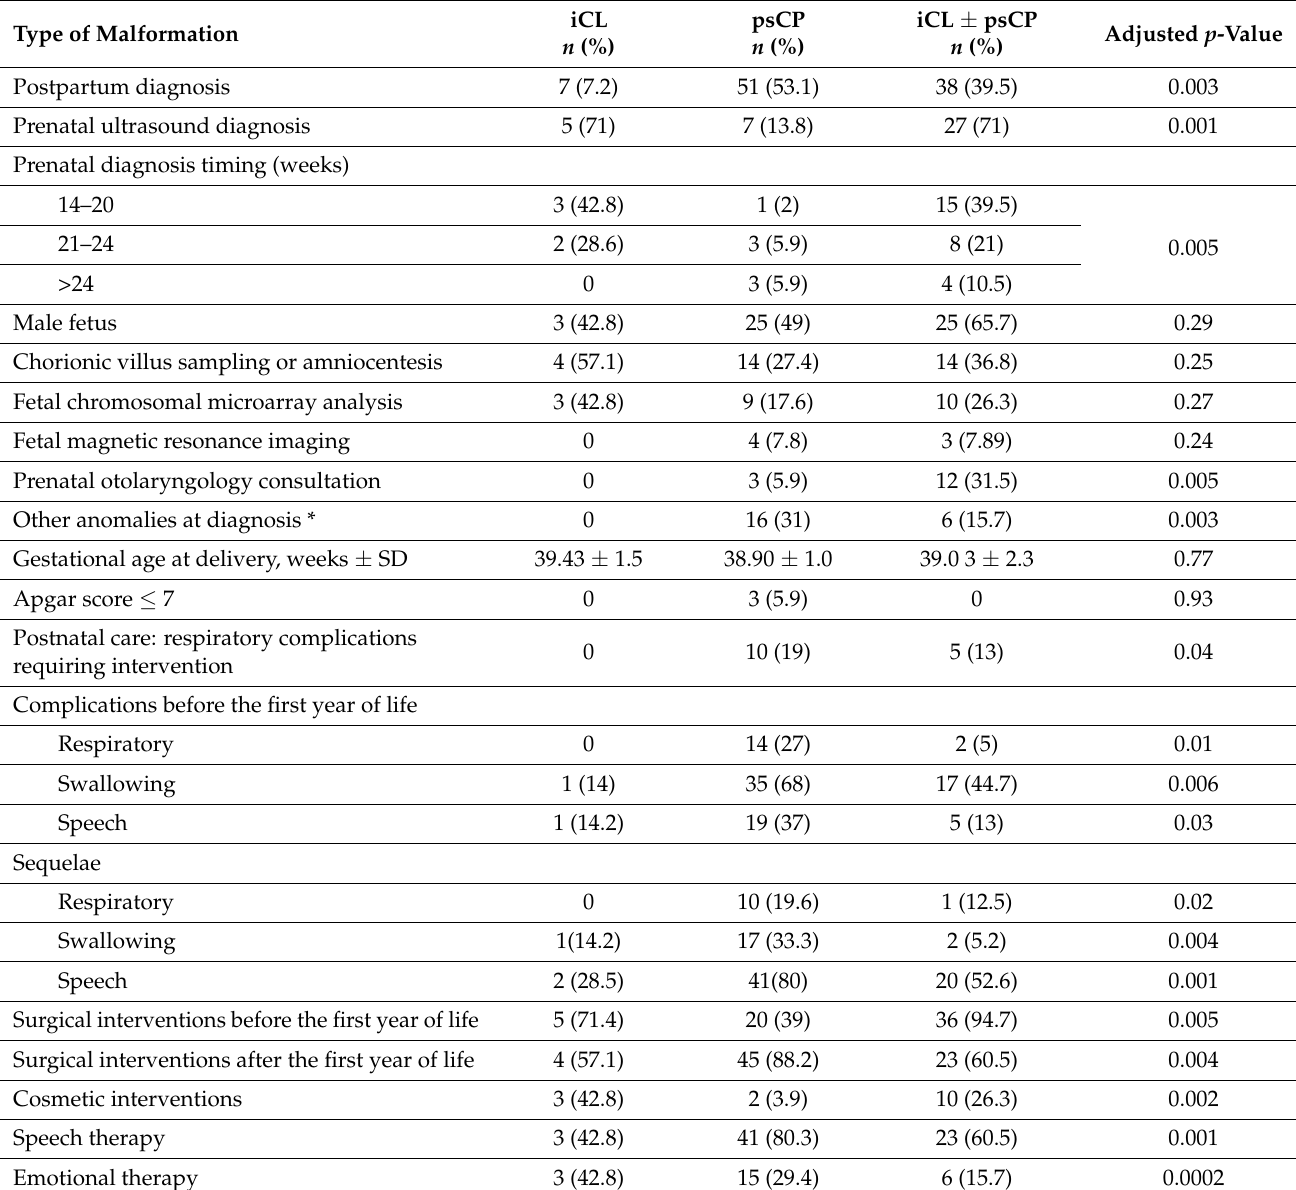
Table 2. Demographic, obstetric, work-up and outcome of fetuses with postpartum diagnosis of iCL versus psCP and combined iCL-psCP ( n =